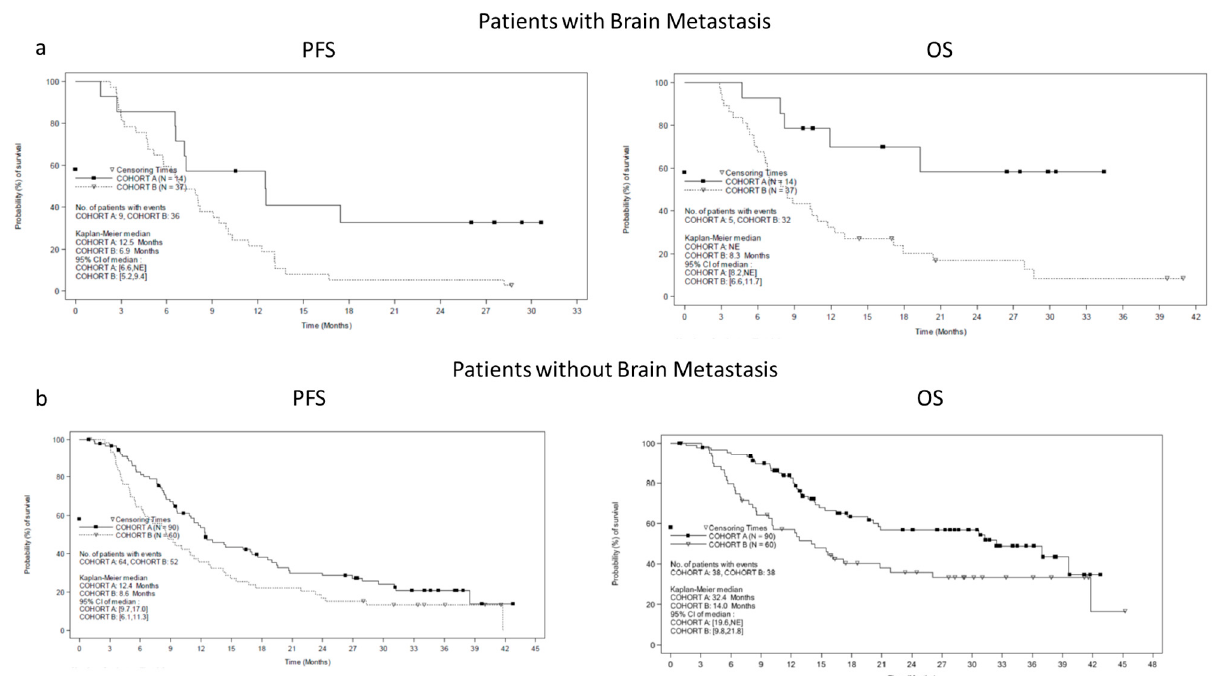
Figure 3. Progression-free survival and overall survival according to brain metastasis in cohorts A and B. PFS and OS in patient with brain metastasis are shown in panel ( a ). In the panel ( b ), PFS and OS in patient without brain metastasis are reported.